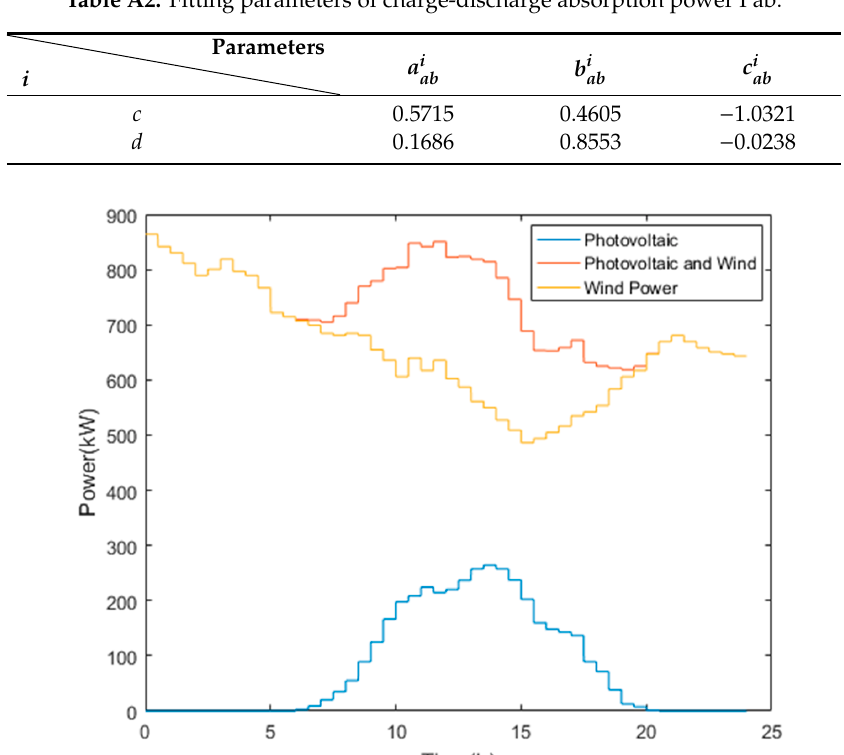
Figure A1. Typical output curve of distributed power.